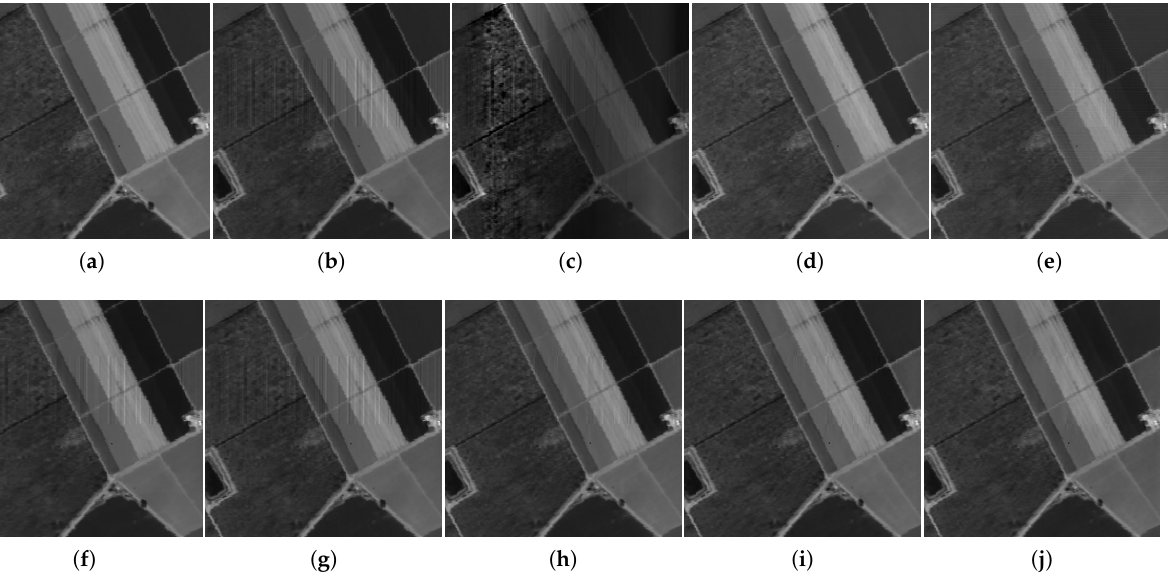
Figure 7. Corrected Salinas images for band 35. ( a ) Original image. ( b ) Degraded image. Images corrected by ( c ) MM, ( d ) ASSTV, ( e ) LRSID, ( f ) that of reference [43], ( g ) PADMM, ( h ) ICSRN, ( i ) SSGN, ( j )